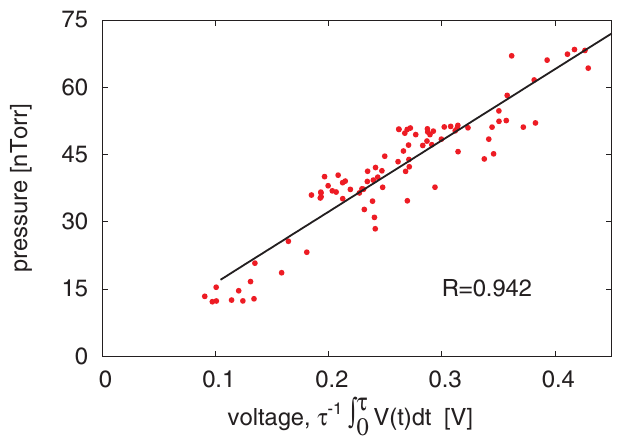
FIG. 11. Summary of all calculated desorption coefficients for the baked staineless steel furface at IR12 during 2004. The error bar is about 50% of the calculated value due to uncertainty in the pumping speed and vacuum pressure readings. The average and rms are 0.004 (cid:12) 0.001 molecules/electron.